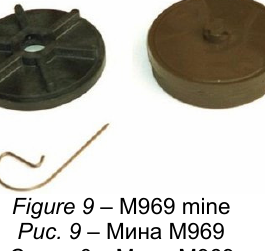
Figure 9 – M969 mine Рис . 9 – Мина М 969 Слика 9 – Мина